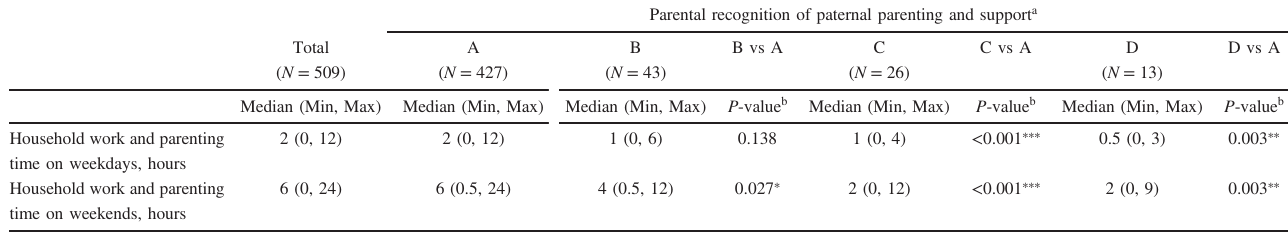
Parental recognition of paternal parenting and support